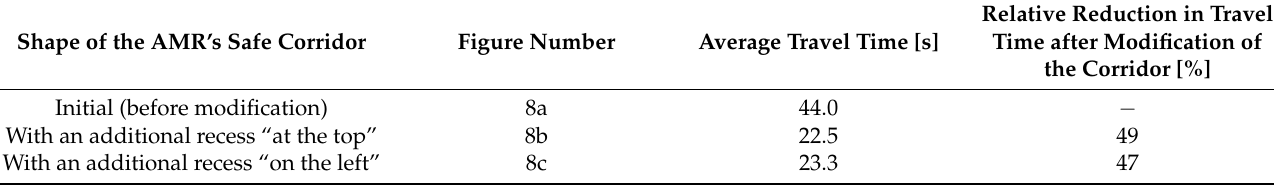
Table 2. Simulated AMR travel times for three different shapes of the robot’s safe corridor. Shape of the AMR’s Safe Corridor Figure Number Average Travel Time [s]